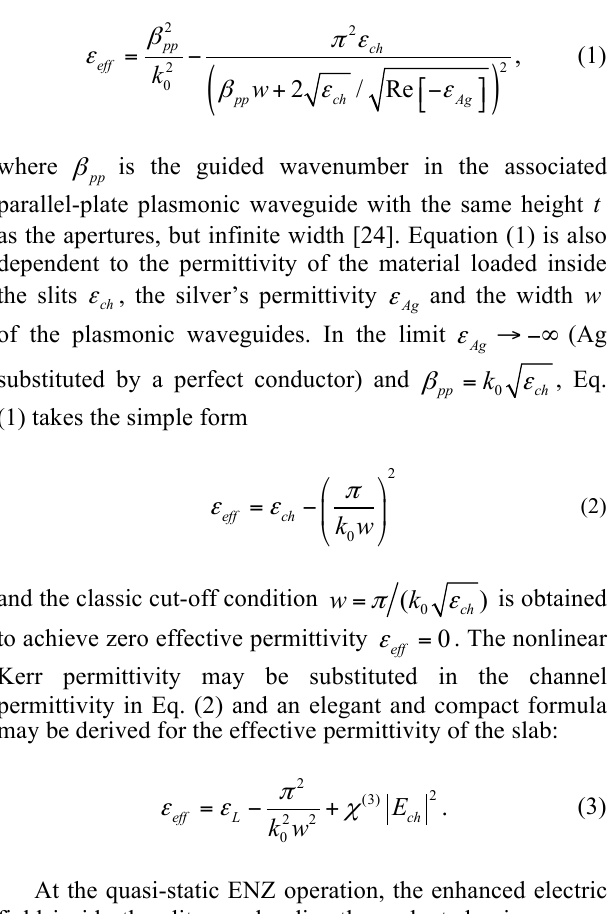
Figure 1: A plane wave impinges at normal incidence on a nonlinear ENZ metamaterial slab. Narrow rectangular apertures loaded with third-order Kerr nonlinear optical materials (red) are carved in an elongated silver screen (light